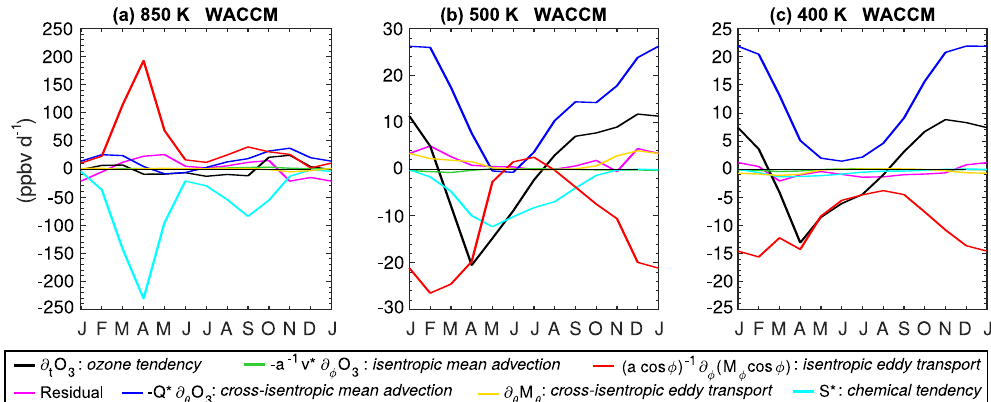
Figure 2. Climatological seasonal cycle of the different terms in the ozone continuity equation (Eq. 1) averaged over the Arctic (70–90 ◦ N) at (a) 850K, (b) 500K, and (c) 400K. WACCM